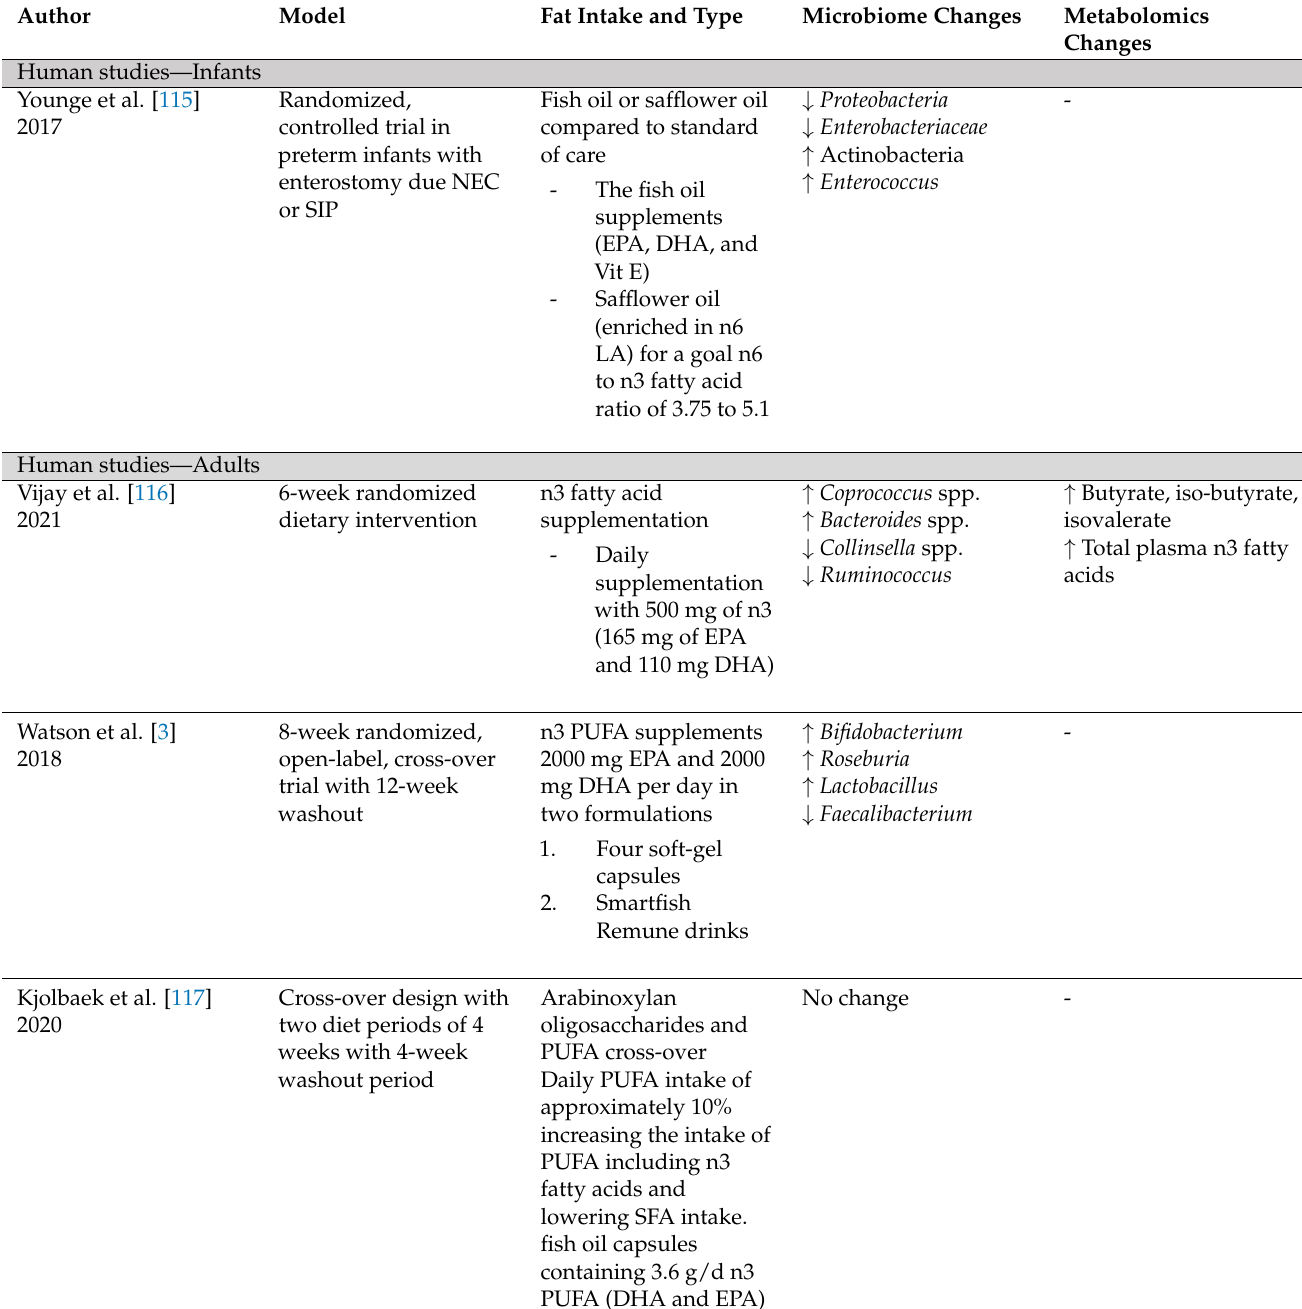
Table 1. Effects of dietary fatty acids on intestinal microbiome in human and animal